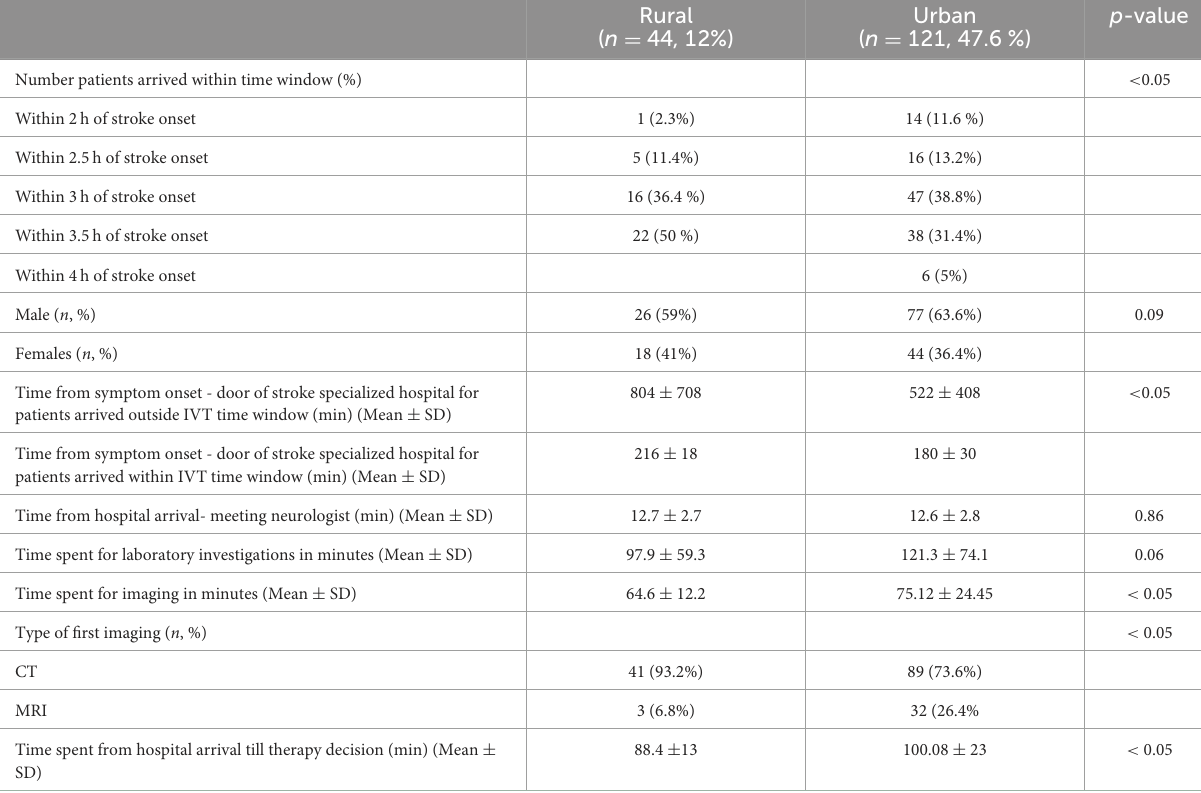
TABLE 4 General demographic characteristics of patients arrived within 4.5h after symptom